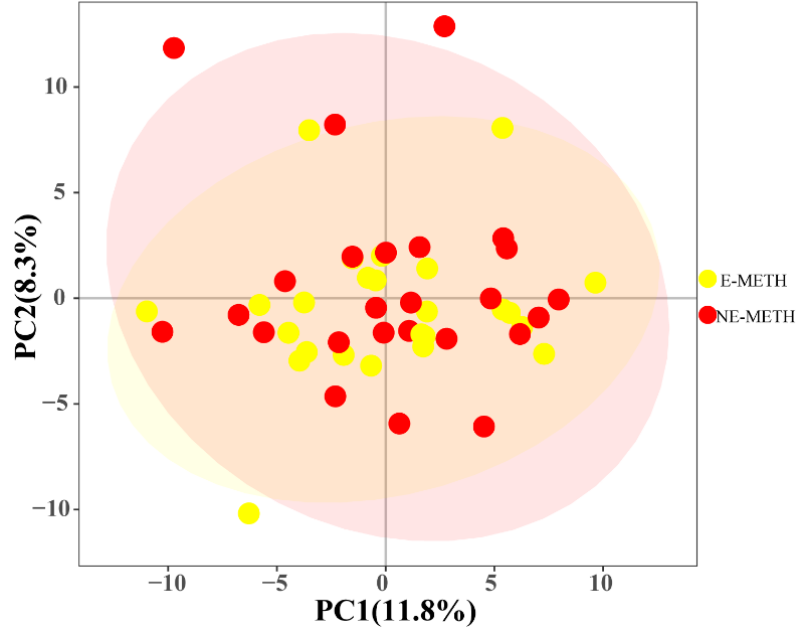
Figure 2. PCA score plot data of the NE-METH group versus the E-METH group.